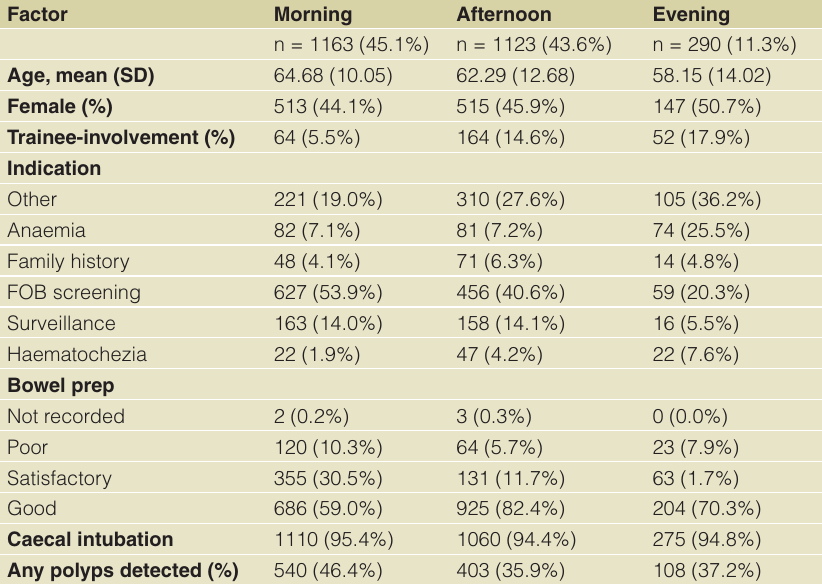
Table 1. Demographic, indication and endoscopic findings by colonoscopy